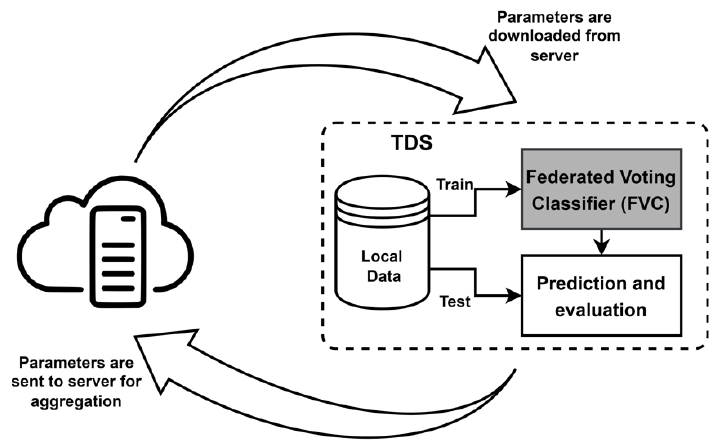
Figure 2. Abstract overview of the proposed framework. Highlighted area depicts the proposed novel federated voting classifier (FVC).